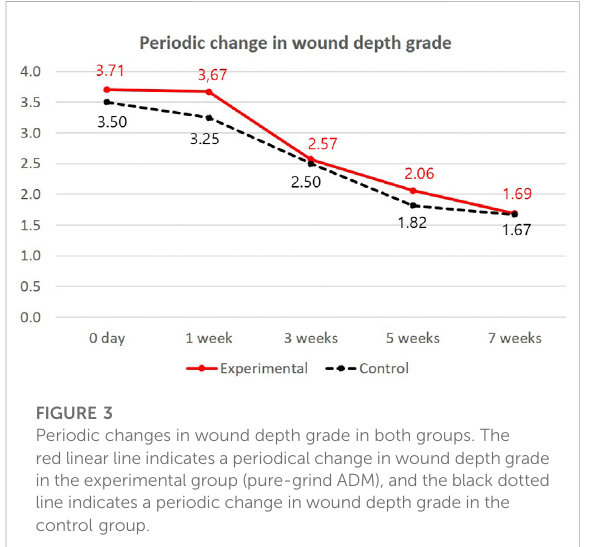
FIGURE 4 Periodic change in granulation tissue percentage in both groups. The red linear line indicates a periodical change in granulation tissue percentage in the experimental group (pure- grind ADM), and the black dotted line indicates a periodic change in granulation tissue percentage in the control